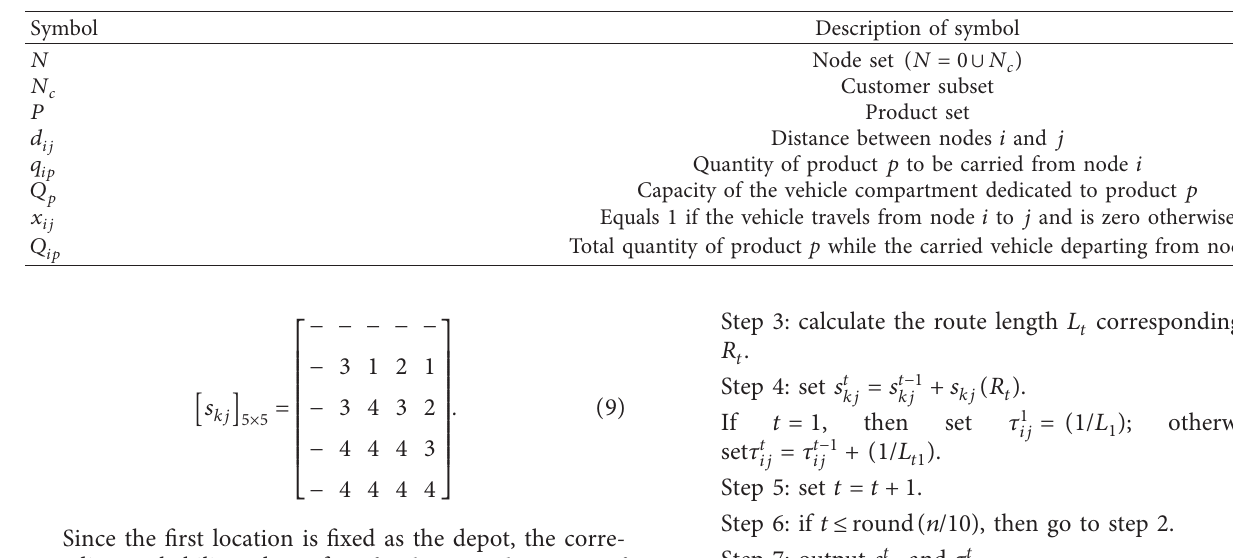
Table 1: Notations applied in the MCVRP